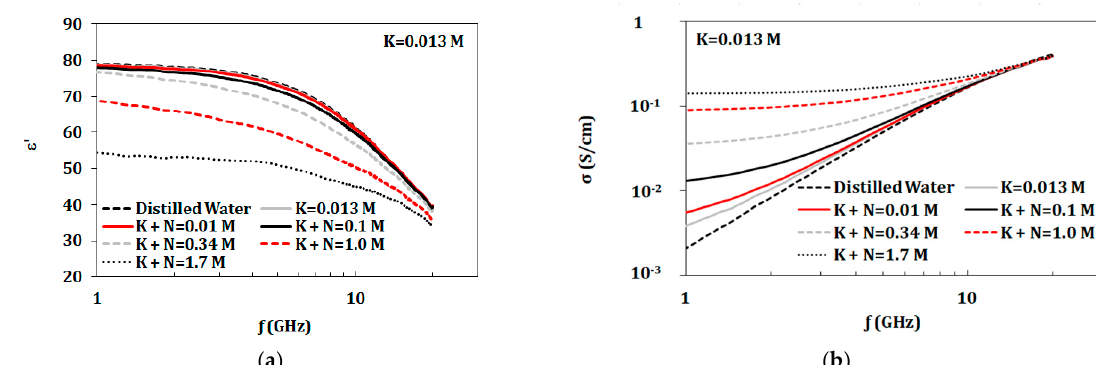
Figure 4. Measured dielectric properties for NaCl solutions at ion concentrations from 0.01 to 1.7 mol/L and KCl with fixed concentration of 0.013 mol/L at temperature 23 °C in the range of 1–20 GHz: ( a ) dielectric constant and ( b ) conductivity (“M” refers to mol/L).